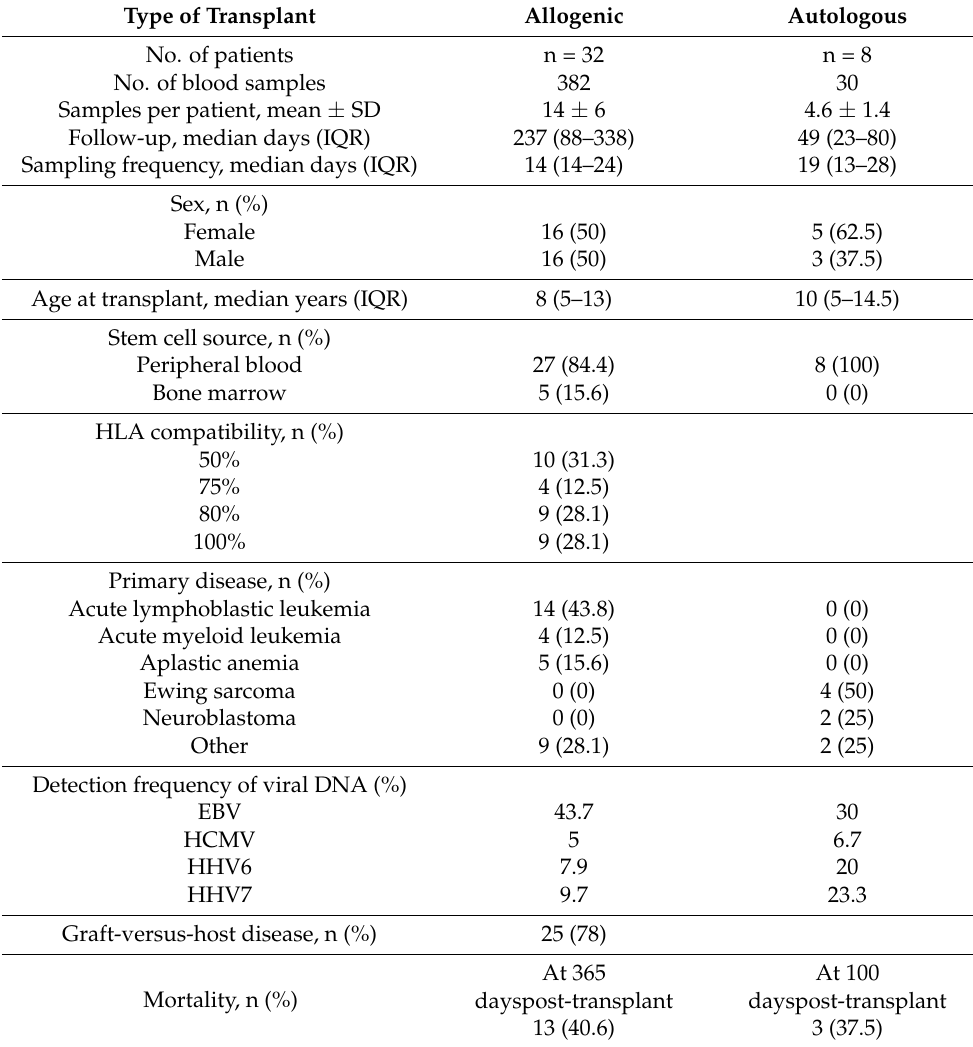
Table 1. Patients (n = 40) and samples (n =